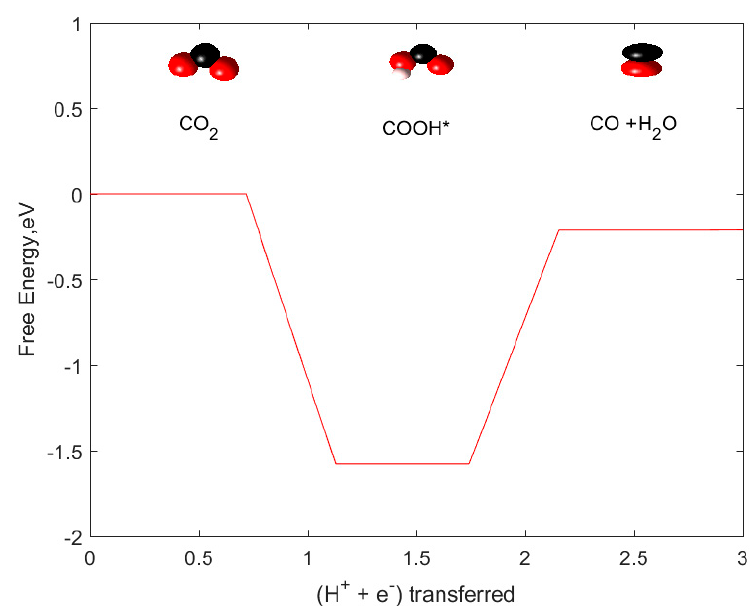
Figure 2. Lowest energy pathway of CO 2 reduction to CO at U = 0 V on WC/graphene. Color code of atoms: red: oxygen, black: carbon, white: hydrogen.